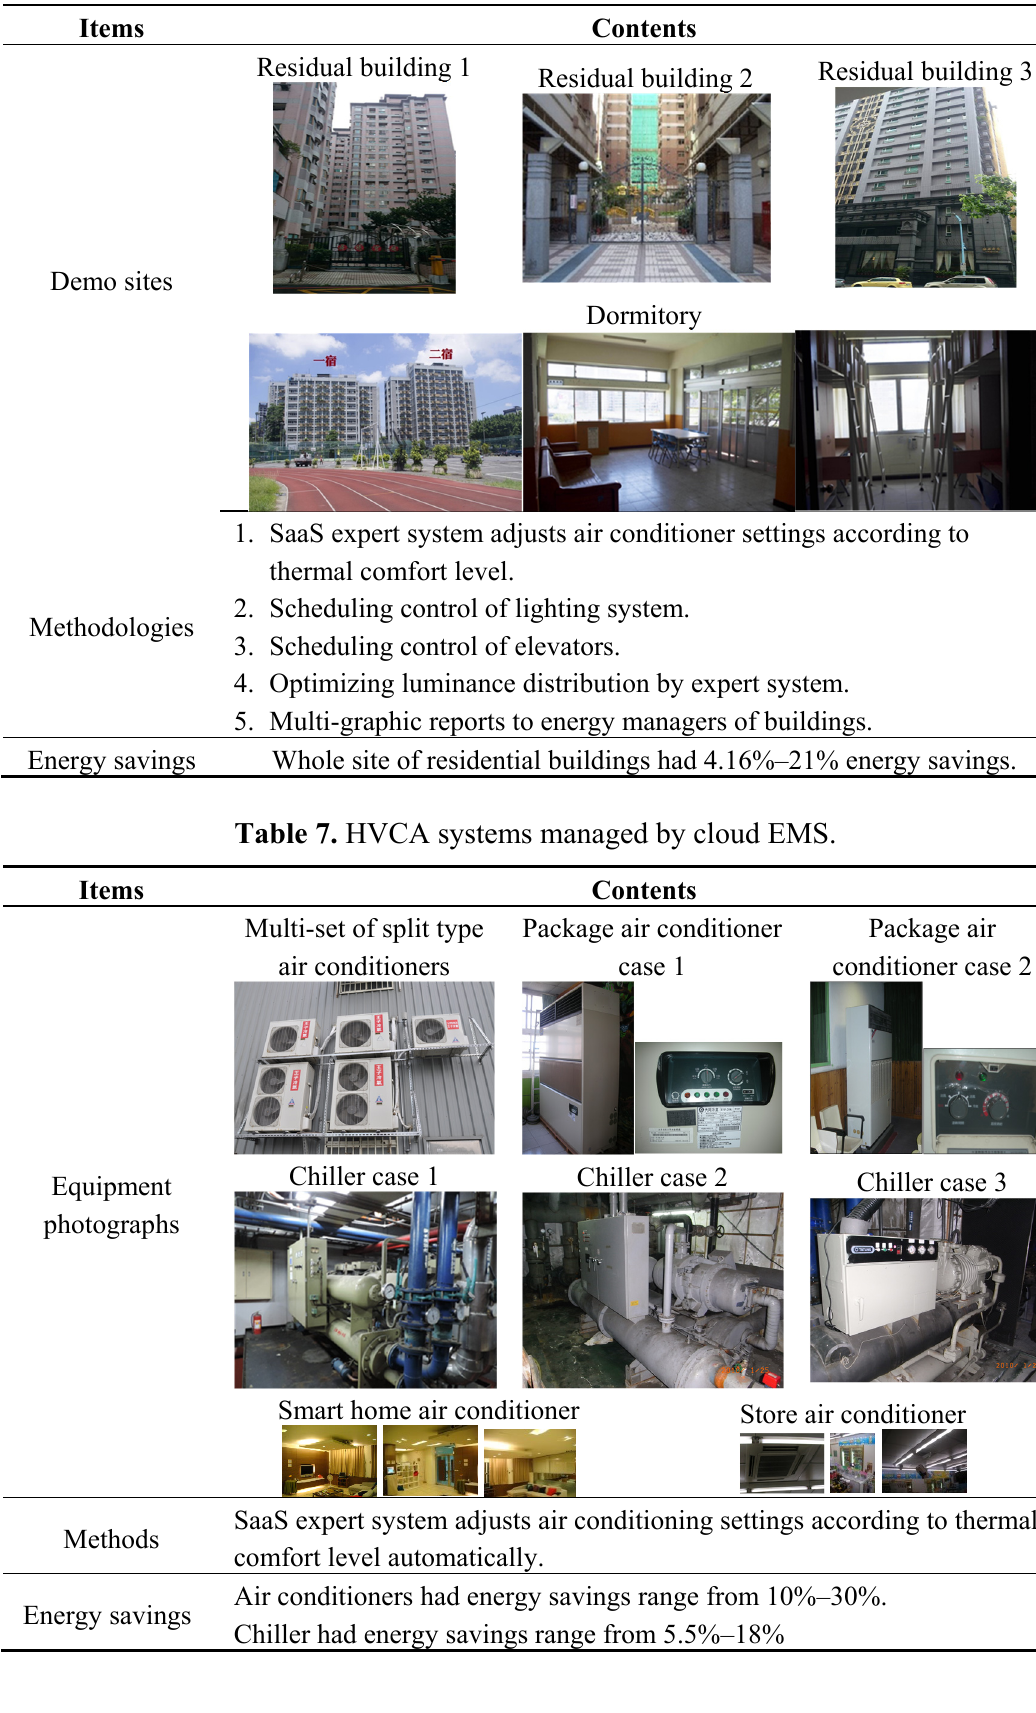
Table 6. Residential buildings managed by cloud EMS.